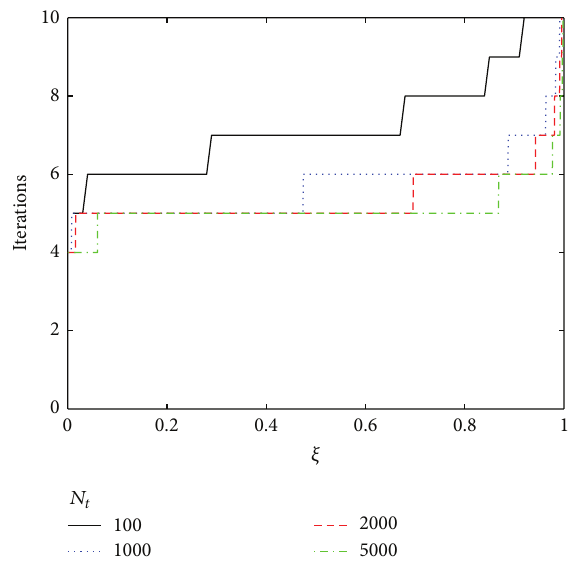
Figure 1: Variation of the SRM iterations with time 𝜉 in Example 1.